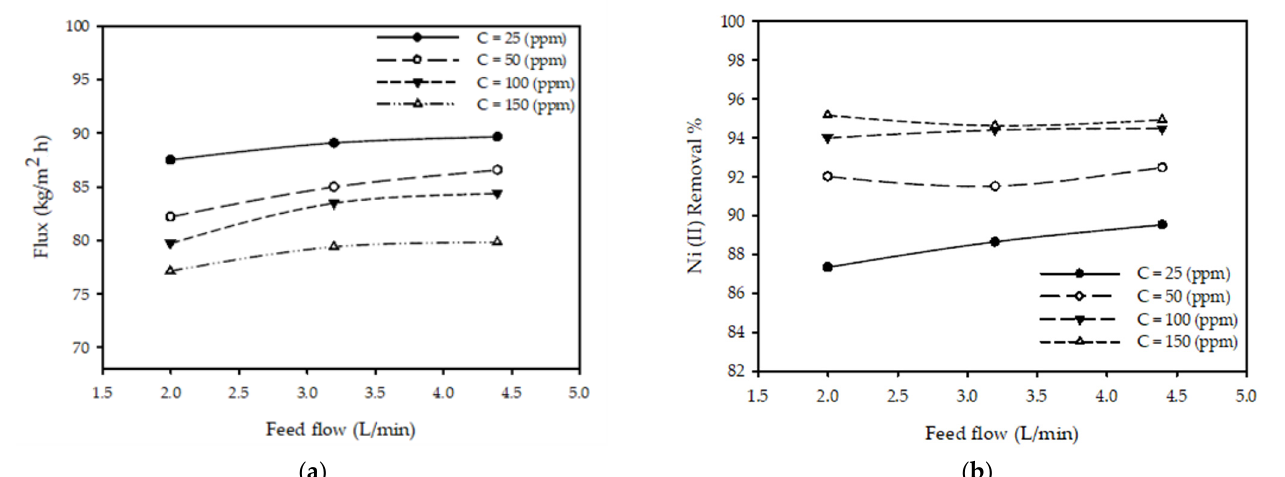
Figure 5. Flow rate impact on ( a ) permeate flux and ( b ) Ni (II) removal % at alternating inlet concentrations with a pressure of 20 bar and a feed temperature of 25 °C.